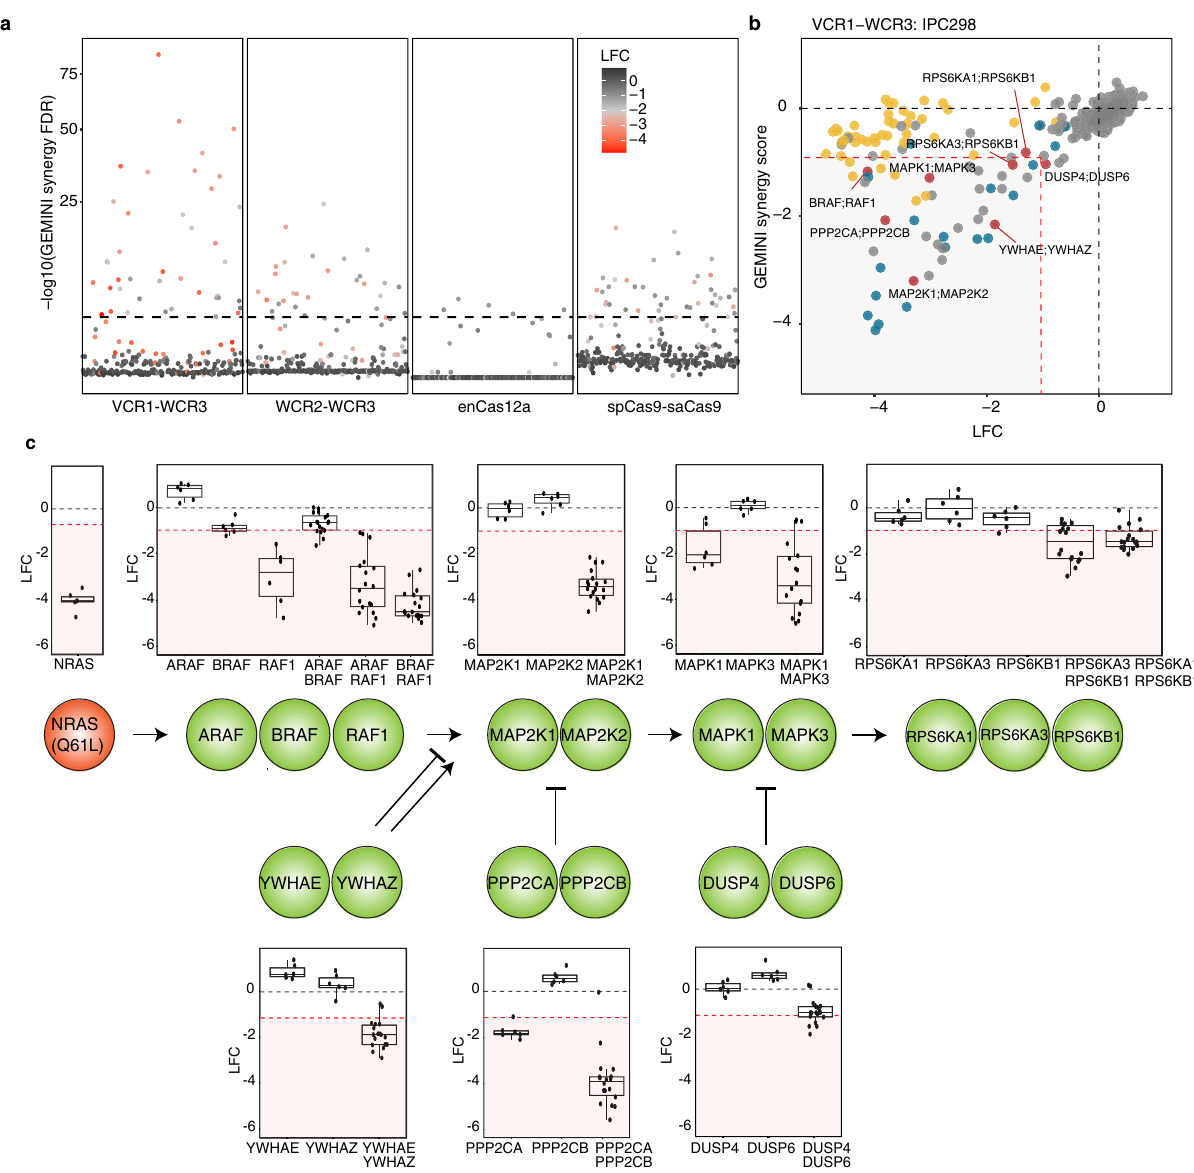
Fig. 5 Positive and negative regulators of the MAPK pathway exhibit synergistic dependencies in NRAS -mutant melanoma. a Manhattan plot of FDRs corresponding to GEMINI synergy scores and color-coded by the LFC of dependencies for paralog pair knockouts in IPC298. The dotted line represents the FDR of 1e-3. b Scatter plot of GEMINI synergy score and LFC of dual knockout in IPC298. Curated paralog pairs of the MAPK pathway are annotated by red dots. Pan-essential paralog pairs or genes are annotated by blue or yellow dots, respectively. c LFC of single or combinatorial gene knockouts of paralog pairs associated with MAPK signaling pathway in IPC298 ( n = 3 biological replicates; 6 independent sgRNAs per gene and 18 independent sgRNA combinations per gene pair). The centerline, lower hinge, and upper hinge correspond to the 50th, 25th, and 75th percentiles, respectively. The upper and lower whiskers extend from the upper and lower hinges to the largest and smallest values no further than 1.5 * IQR (interquartile range). Source data are provided in the Source Data 5 ′ -AGGCACTTGCTCGTACGACGCGTCTCAAGAT [enCas12a crRNA, 23 nt] TAATTTCTACTGTCGTAGAT [enCas12a crRNA, 23nt] TTTTTTGAATcGA- GACGTTAAGGTGCCGGGCCCACAT-3 ′ . The 134nt oligos included an engi- neered variant of the wild-type direct repeat for AsCas12a between the two 23-nt- long crRNAs 12 . The oligonucleotides pool was ampli fi ed and cloned into pRDA_052 (Addgene #136474) as described above. The guide expression vector pRDA_052 was digested with BsmBI (New England Biolabs), de-phosphorylated with Antarctic phosphatase (New England Biolabs), and concentrated using PCR cleanup columns (Life Technologies).